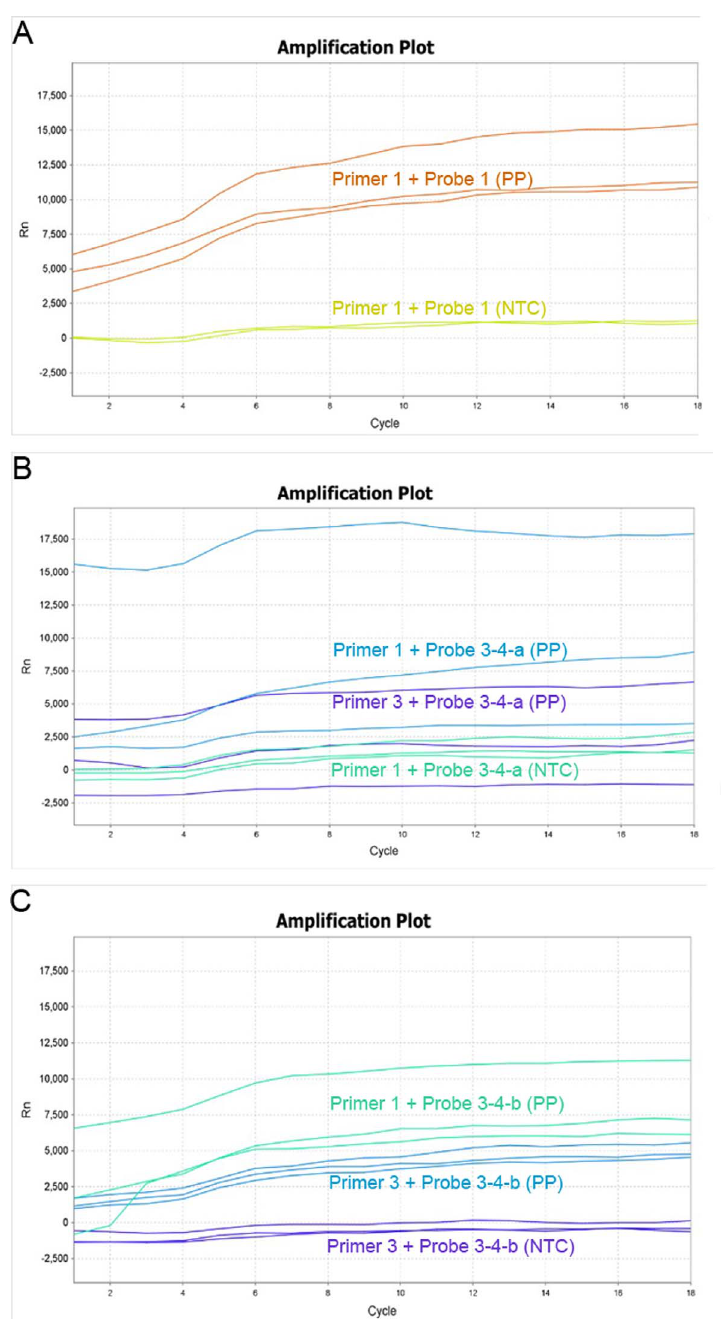
Figure 4. Fluorescence ampli fi cation curve of primer and probe combination. (A) The fl uorescence ampli fi cation curve of Primer 1 + Probe 1 is very high in the positive plasmid control of T. gondii for three repeats; (B) The fl uorescence curve of Primer 1 + Probe 3 – 4-a and Primer 3 + Probe 3 – 4-a indicates no signi fi cant ampli fi cation, and the consistency is poor for three repeats; (C) The fl uorescence curve of Primer 1 + Probe 3 – 4-b and Primer 3 + Probe 3 – 4-b also shows no signi fi cant ampli fi cation, and the ampli fi cation consistency of Primer 1 + Probe 3 – 4-b is poor for the three repeats. PP: positive plasmid control; NTC: negative